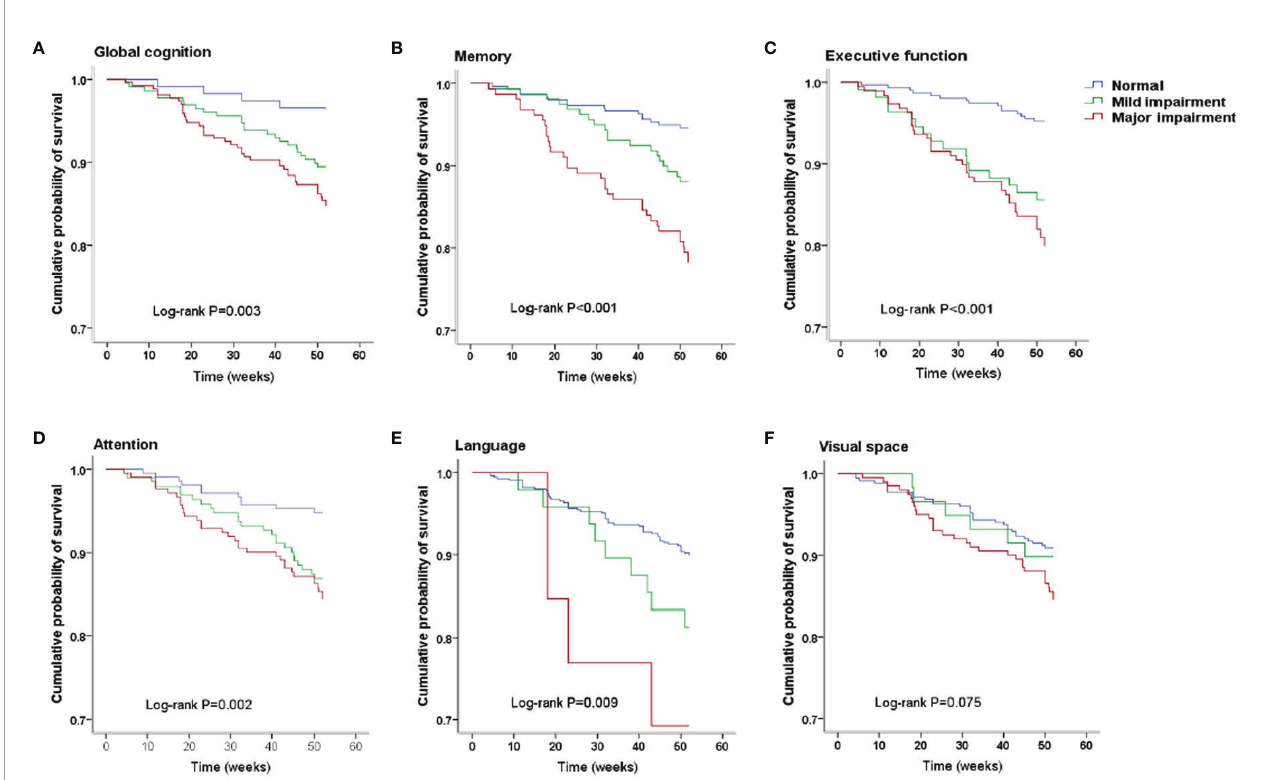
FIGURE 1 | Kaplan – Meier survival curves. (A) Survival analysis strati fi ed by global cognition. (B) Survival analysis strati fi ed by memory. (C) Survival analysis strati fi ed by executive function. (D) Survival analysis strati fi ed by attention. (E) Survival analysis strati fi ed by language. (F) Survival analysis strati fi ed by visual